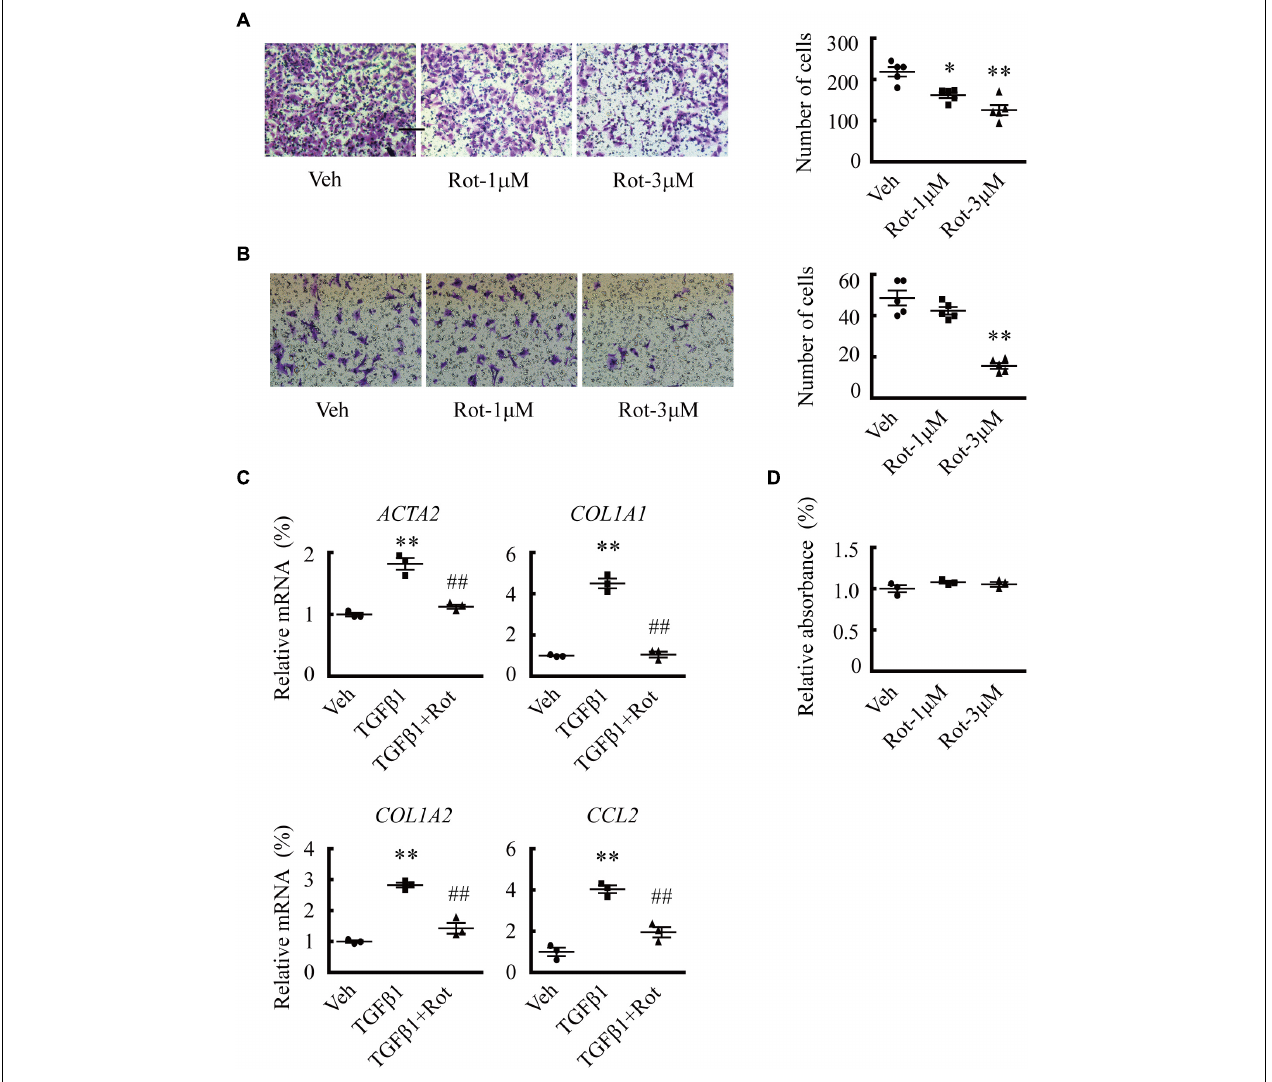
FIGURE 3 | Upregulation of large-conductance and Ca 2 + -activated K + (BK) channel activity by rottlerin inhibits hepatic stellate cell (HSC) migration and fibrosis-related gene expression in vitro . (A,B) Representative images ( left ) and averaged number of migrated cells ( right ) showing the inhibitory effects of rottlerin (Rot), a BK channel activator, on the migration of human LX2 cells (A) and activated primary rat HSCs (B) at the indicated concentrations ( ∗ p < 0.05, ∗∗ p < 0.01 compared with vehicle). (C) Relative mRNA expression levels of ACTA2 , COL1A1 , COL1A2 , and CCL2 in human LX2 cells with the indicated treatments for 24 h. (D) Normalized cell viability of LX2 cells measured under the indicated conditions ( ∗∗ p < 0.01 compared with vehicle, ## p < 0.01 compared with the TGF β 1-treated group).